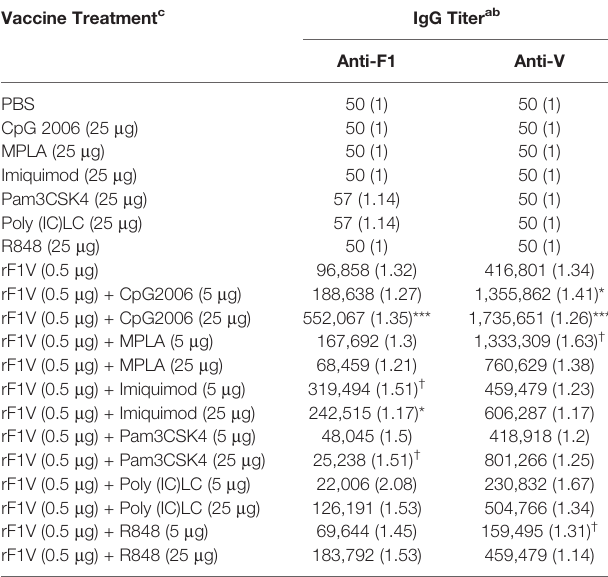
TABLE 4 | Effect of Pam3CSK4 (TLR2), Poly(IC)LC (TLR3), MPLA (TLR4), Imiquimod (TLR7), R848 (TLR7/8) and CpG (TLR9) with rF1V vaccine on F1 and V antibody response in BALB/c mice.